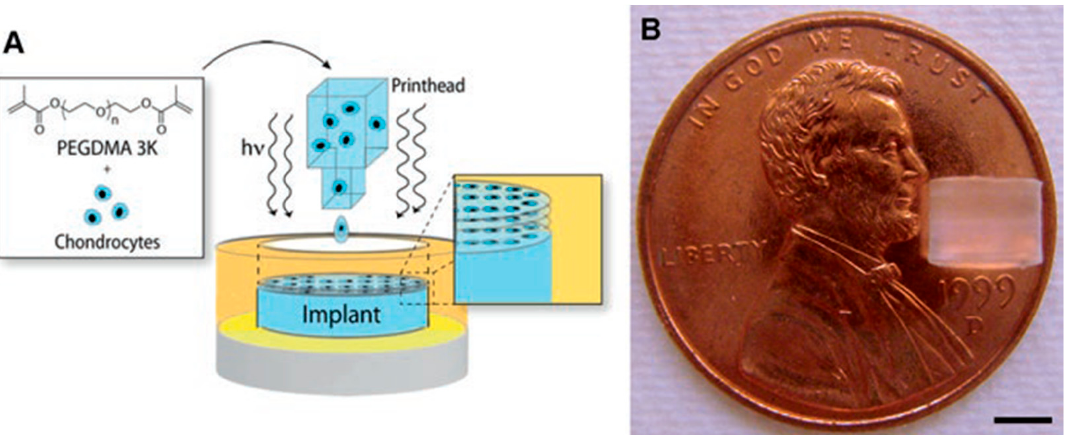
Figure 10. Bioprinted neocartilage tissue using TIJP with continuous photopolymerization. ( A ) Schematic of cartilage bioprinting with simultaneous photopolymerization and layer-by-layer as- sembly. ( B ) A printed neocartilage tissue of 4 mm in diameter and 4 mm in height. Scale bar, 2 mm [130].